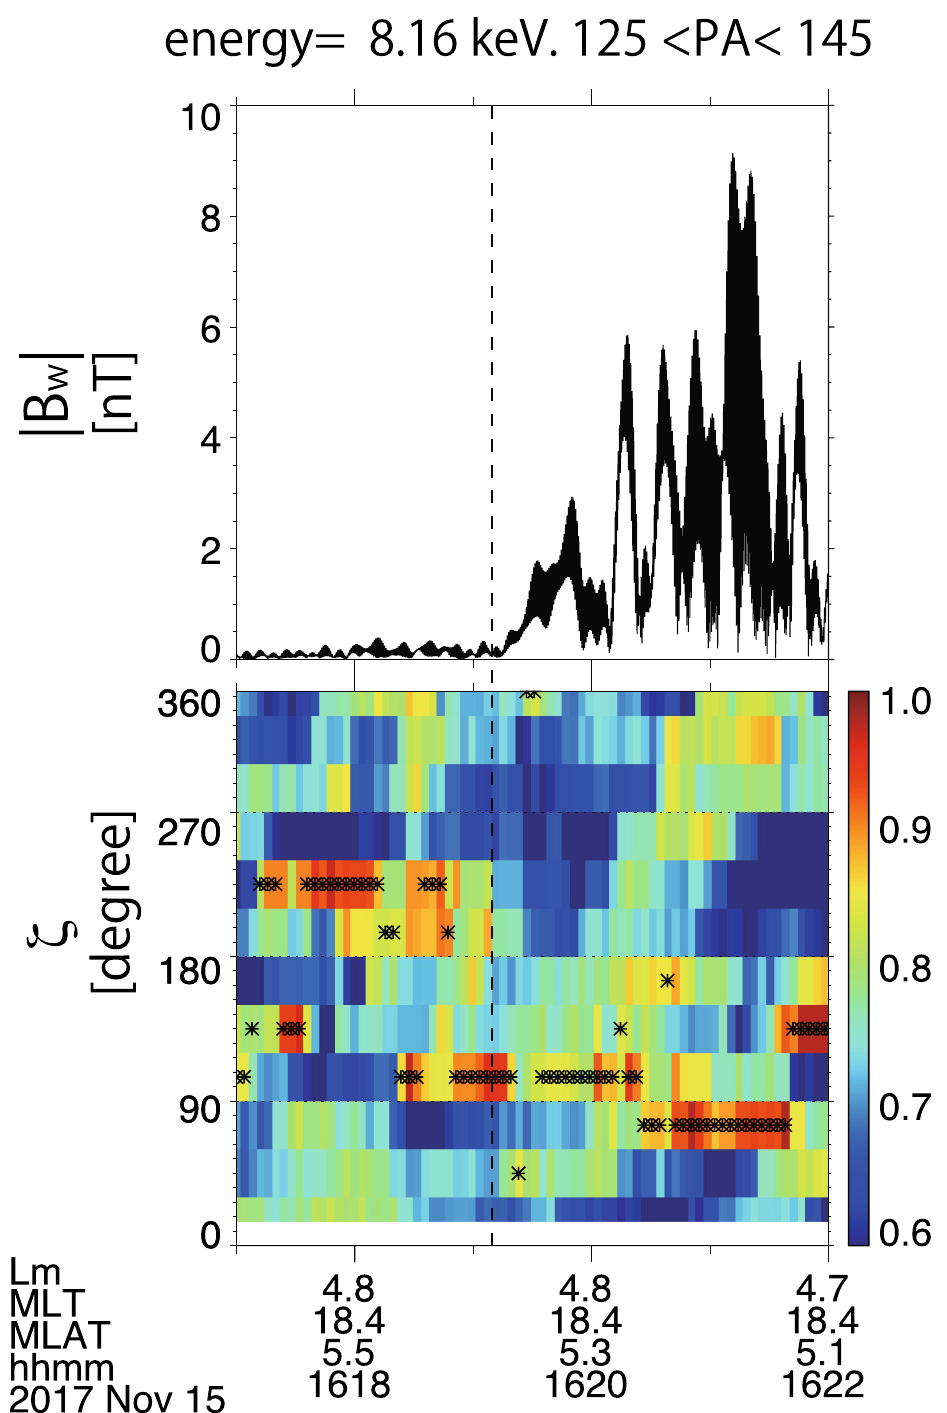
Figure 4. ( a ) The magnetic field wave amplitude between 0.6 and 0.75 Hz. ( b ) Flux distribution of the protons in ζ direction normalized by the maximum value. Dots in the ( b ) indicates the maximum flux in each time. (Created by using IDL 8.8 https:// www. l3har risge ospat ial. com/ Softw are- Techn ology/